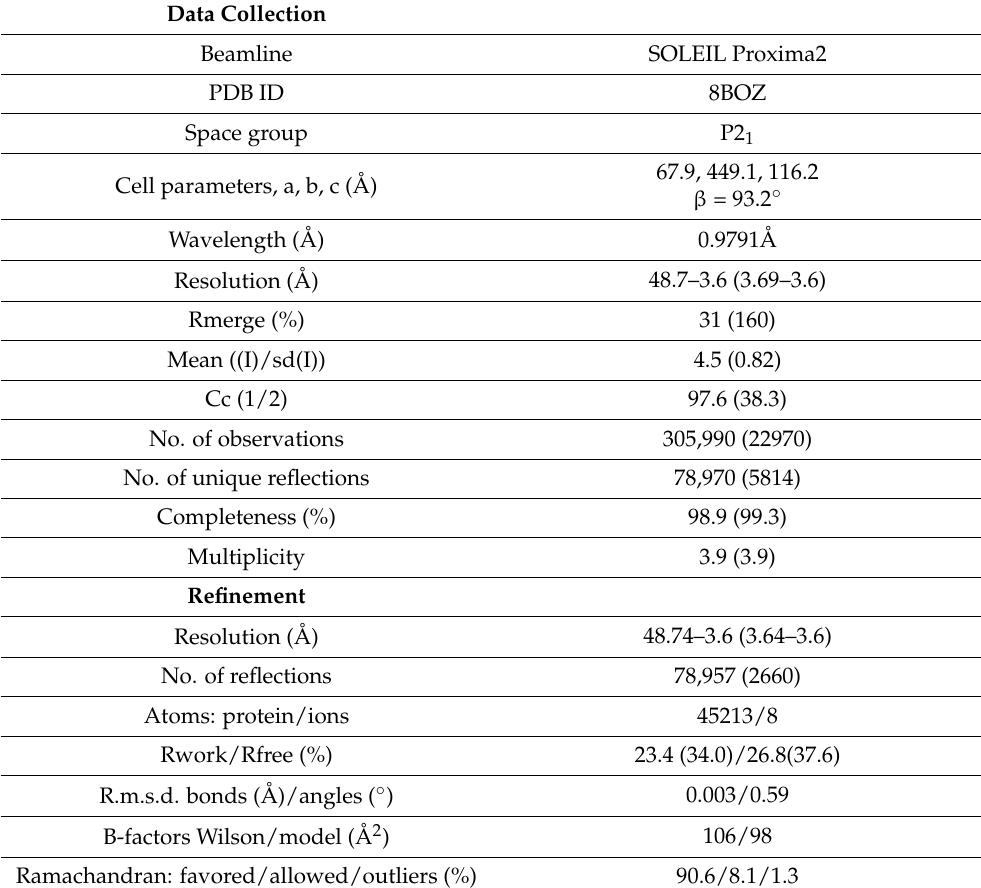
Table 1. Data collection and refinement statistics. Values in parenthesis refer to the highest resolution bin. Data